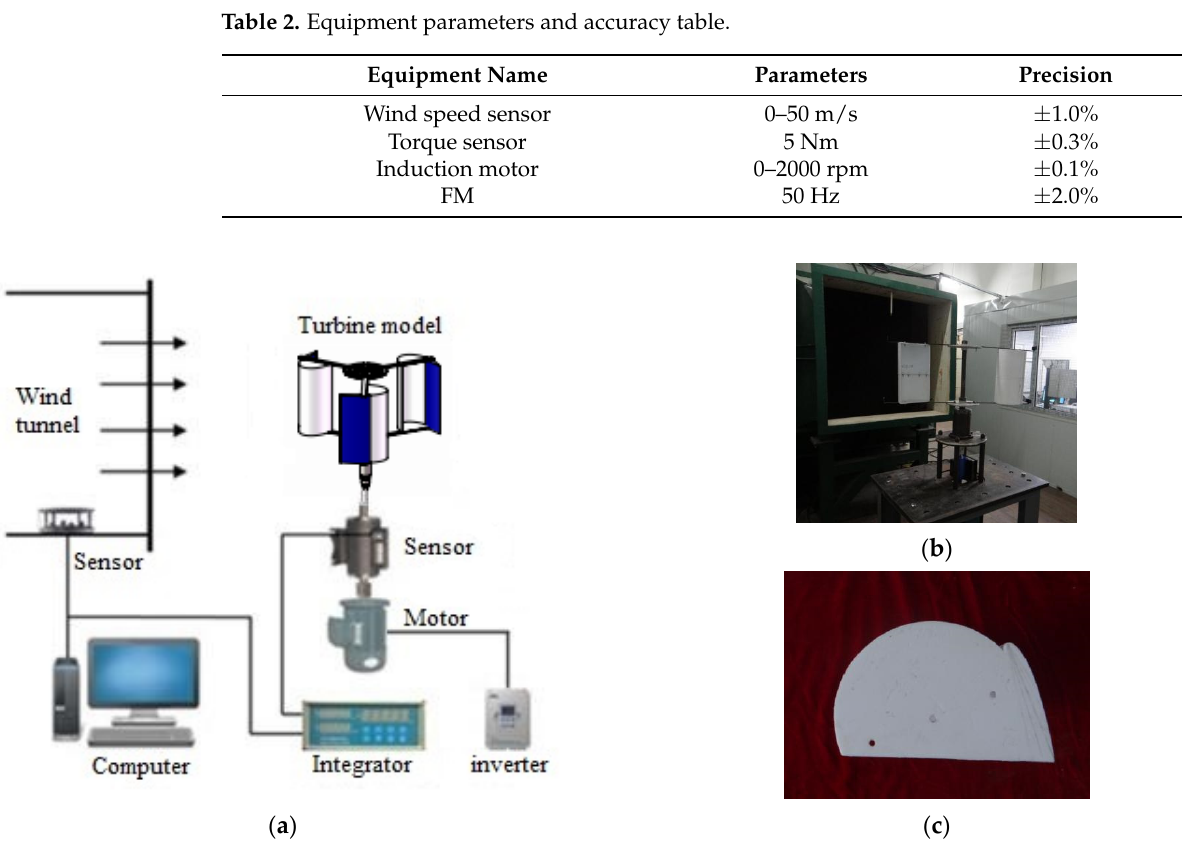
Figure 9. Static torque test system of LDCS. ( a ) General diagram of the test system of LDCS; ( b ) actual test model of LDCS; ( c ) test model of the lift-drag bladed.